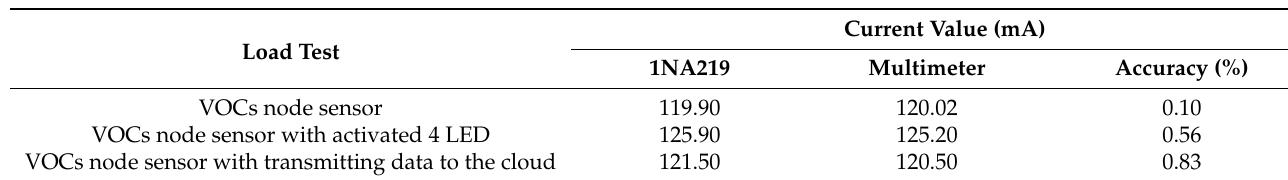
Table 5. Current measurements.